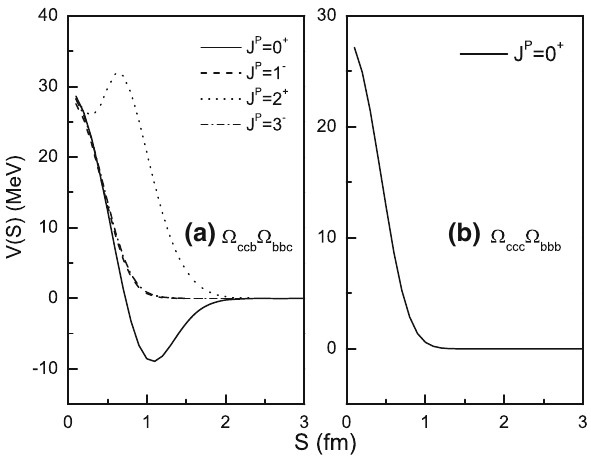
Fig. 2 The effective potential of the Ω ccb Ω bbc and Ω ccc Ω bbb systems